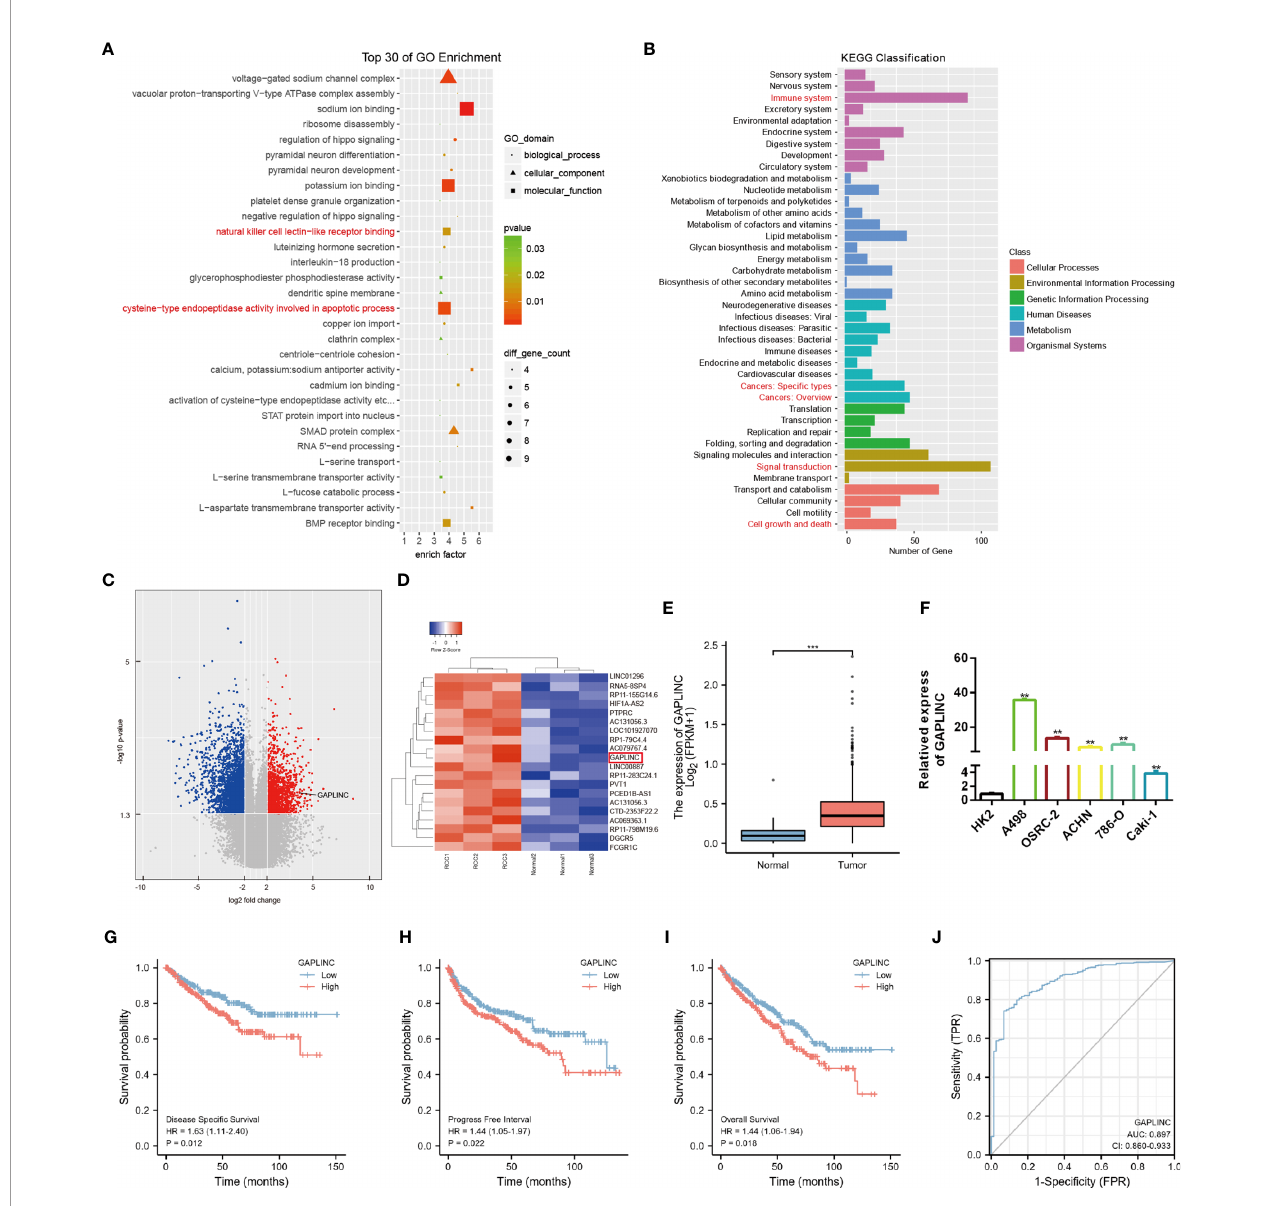
FIGURE 1 | GAPLINC expression is upregulated in RCC and associated with a poor prognosis. (A) Top 30 enriched GO terms of the differentially expressed lncRNAs. (B) KEGG pathway enrichment analysis of differentially expressed genes. (C) The volcano plot shows the expression pro fi les of lncRNAs. (D) Heatmap of the top 20 lncRNAs by expression that are differentially expressed. Red represents high expression, and green represents low expression. (E) GAPLINC expression levels in whole tumor tissues and normal tissues in TCGA cohorts. (F) RT-qPCR analysis of GAPLINC expression in a human normal renal epithelial cell line (HK-2) and four human RCC cell lines (A498, OSRC-2, ACHN, 786-O, Caki-1). Kaplan-Meier survival analysis according to GAPLINC expression showing the DSS (G) , PFI (H) and OS (l) of RCC patients from the TCGA database. (J) ROC curve analysis of the sensitivity and speci fi city of GAPLINC. **p < 0.01; ***p <